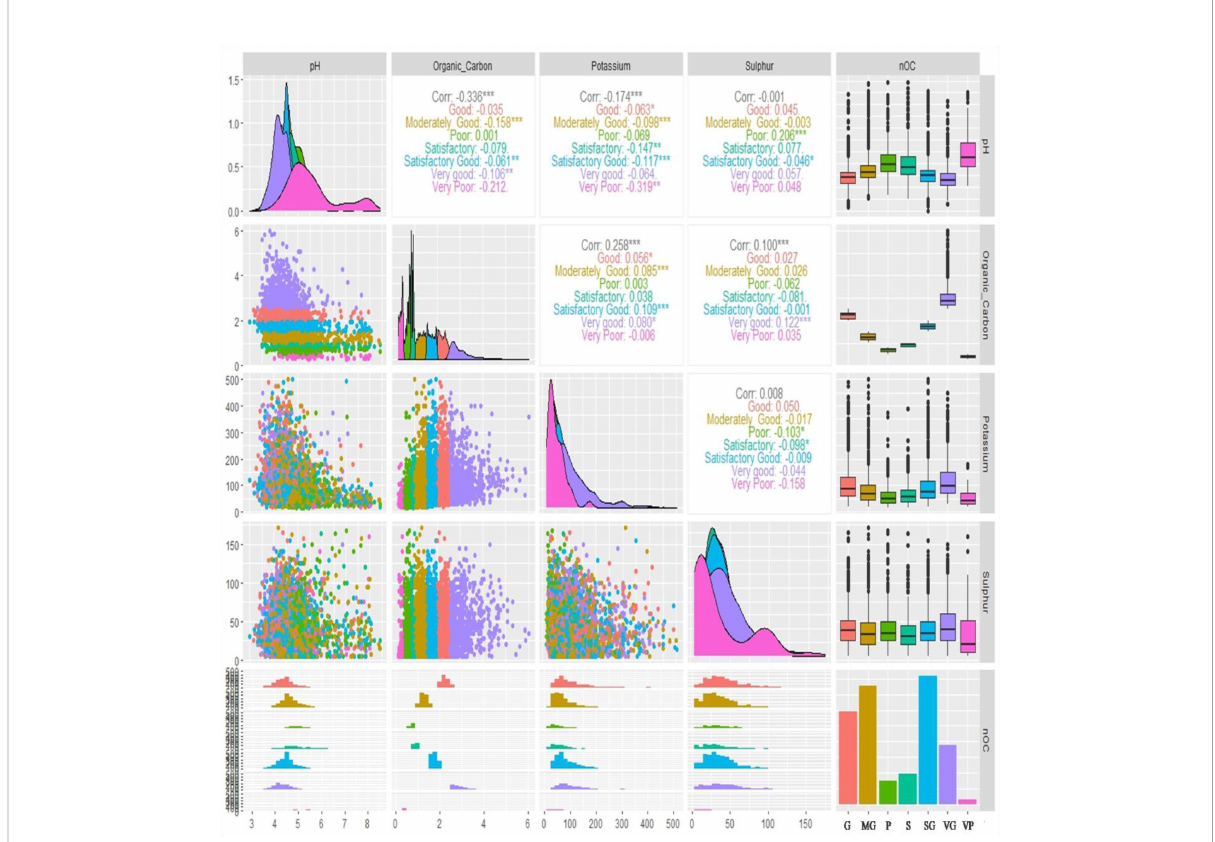
FIGURE 5 Bivariate correlations of reported soil parameters (pH, organic carbon, available potassium, and available sulphur) of 7300 analyzed soil samples against different categories of soil organic carbon (OC) represented by box plot, density, scatter, histogram and bar diagram (in bar diagram G, Good; MG, Moderately Good; P, Poor; S, Satisfactory; SG, Satisfactory Good; VG, Very Good and VL, Very poor; here ‘ Organic_Carbon ’ is ‘ OC ’ , Potassium is ‘ available potassium (K) as K 2 O ’ abbreviated as ‘ AK ’ in the manuscript and Sulphur is ‘ available sulphur ’ abbreviated as ‘ AS ’ in the manuscript; Signi fi cance codes: “ *** ” at 0.001%, “ ** ” at 0.01% and “ * ” at 0.05%